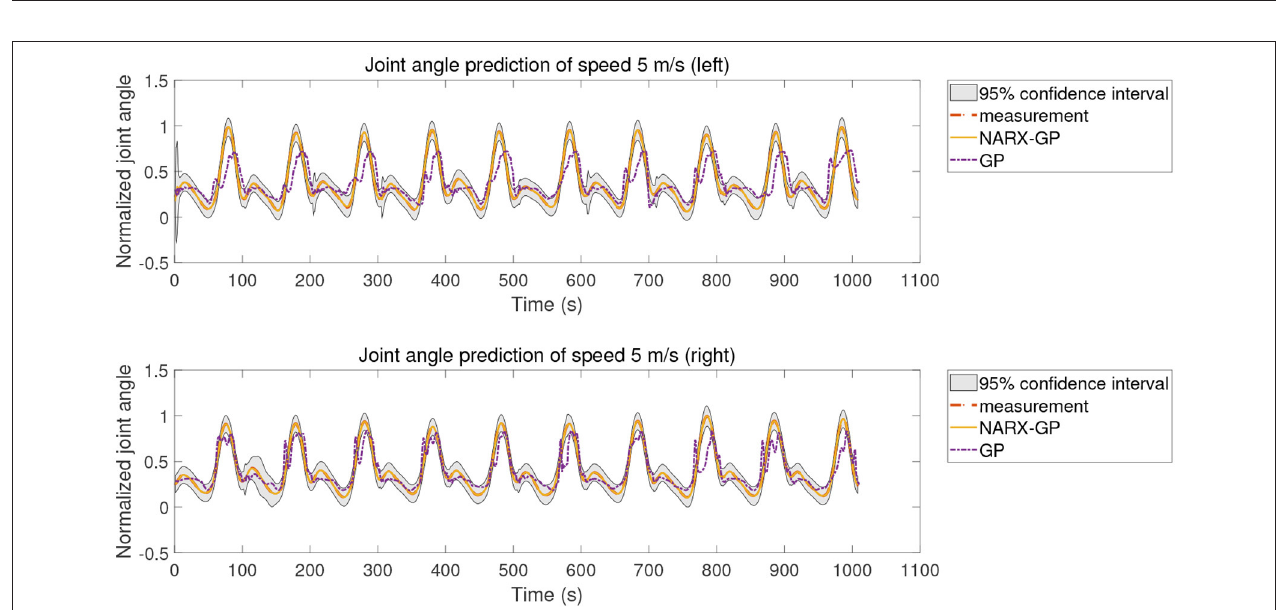
FIGURE 13 | Joint angle prediction of 5 m/s